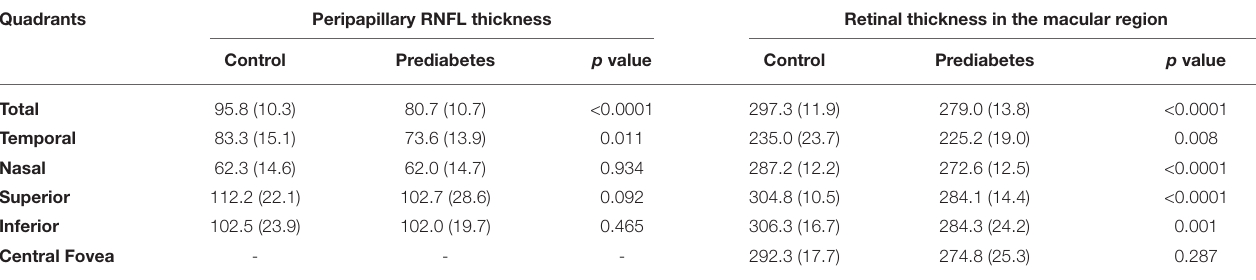
TABLE 2 | Thickness ( µ m) changes of peripapillary retinal nerve fiber layer (pRNFL) and retina in the macular region compared between control and prediabetes. Quadrants